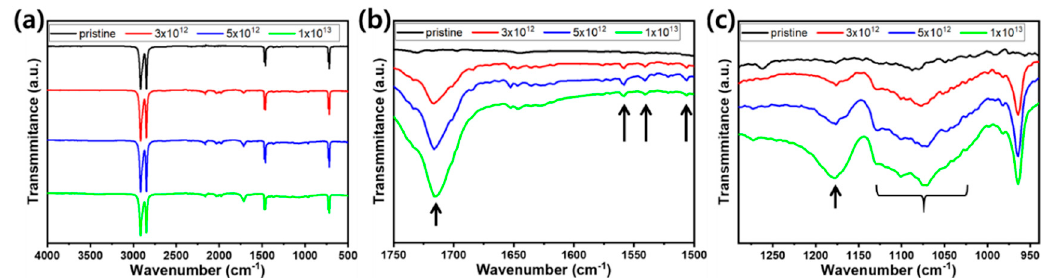
Figure 8. FT-IR spectra of pristine and irradiated HDPE in ( a ) 4000–500 cm − 1 , ( b ) 1750–1500 cm − 1 , and ( c ) 1290–940 cm − 1 wavenumber ranges.